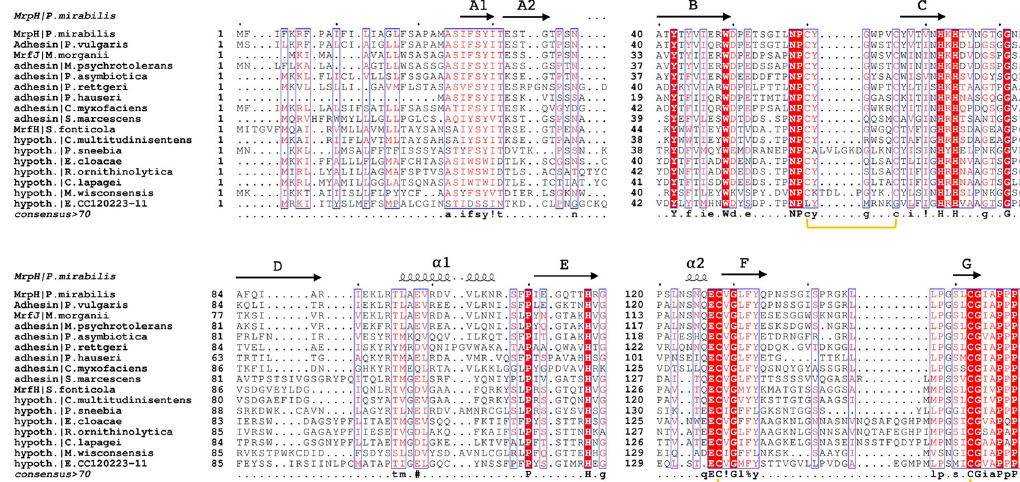
Fig 3. Multiple sequence alignment of representative MrpH ntd amino acid sequences. Aligned MrpH ntd amino acid sequences from 16 different organisms, with residues numbered according to their position in the native sequence. Identical residues are highlighted with red shading and white text, and similar residues with a blue frame and red text. The top secondary- structure depiction and bottom disulfide bond indications (shown as yellow brackets) are derived from the MrpH ntd structure.